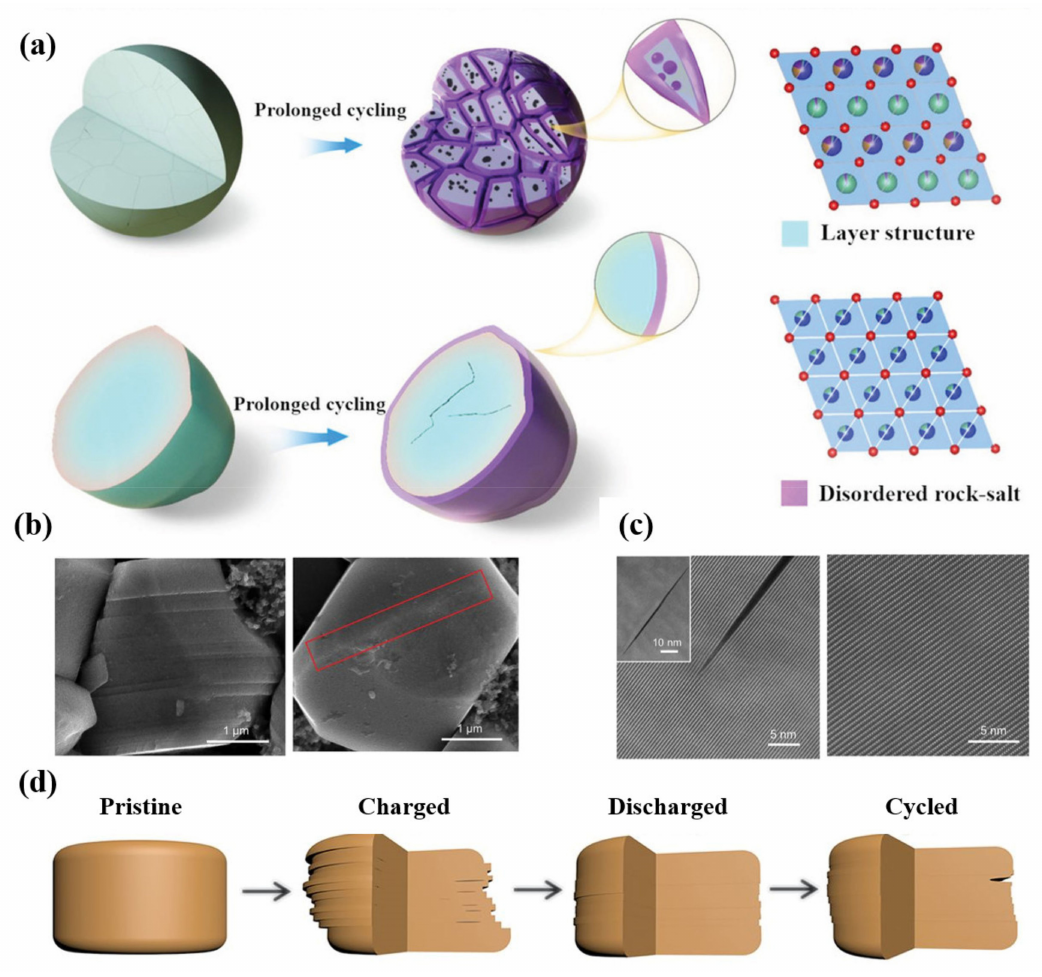
Figure 9. ( a ) PC–NCM622 particles and SC–NCM622 particles after long–term cycling. Blue spheres represent transition metal ions, green spheres represent lithium ions, and red spheres represent oxygen ions. Reproduced with permission from ref. [105]. Copyright 2022 John Wiley and Sons. ( b ) SEM image of single-crystalline NCM76 initially charged to 4.8 V and discharged to 2.7 V (after being charged to 4.8 V). ( c ) STEM images of single-crystalline NCM76 at charge status and discharge status (cycled in a full cell between 2.7 and 4.4 V for 120 cycles). ( d ) Schematic diagram for the structural evolution of single-crystalline NCM76 during cycling. Reproduced with permission from ref. [107]. Copyright 2020 The American Association for the Advancement of